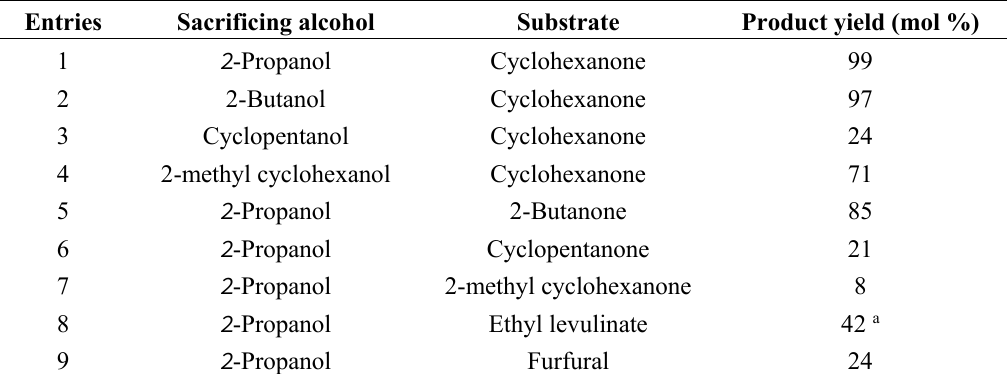
Table 1. Results from MPV catalytic tests in presence of